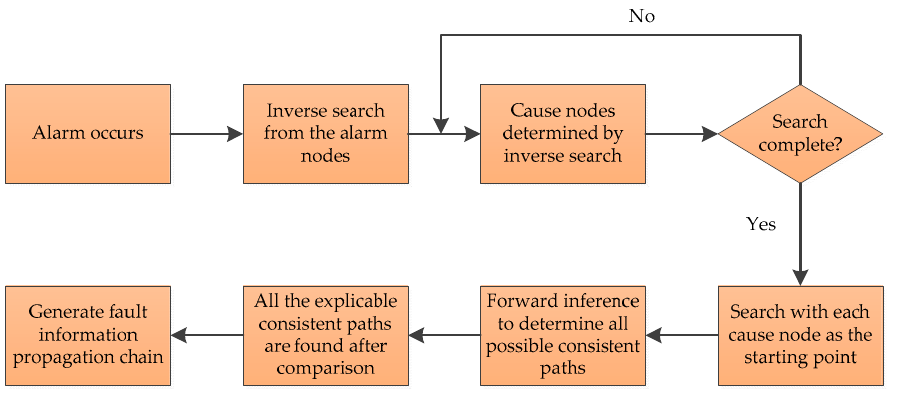
Figure 4. The flow chart of bidirectional inference.